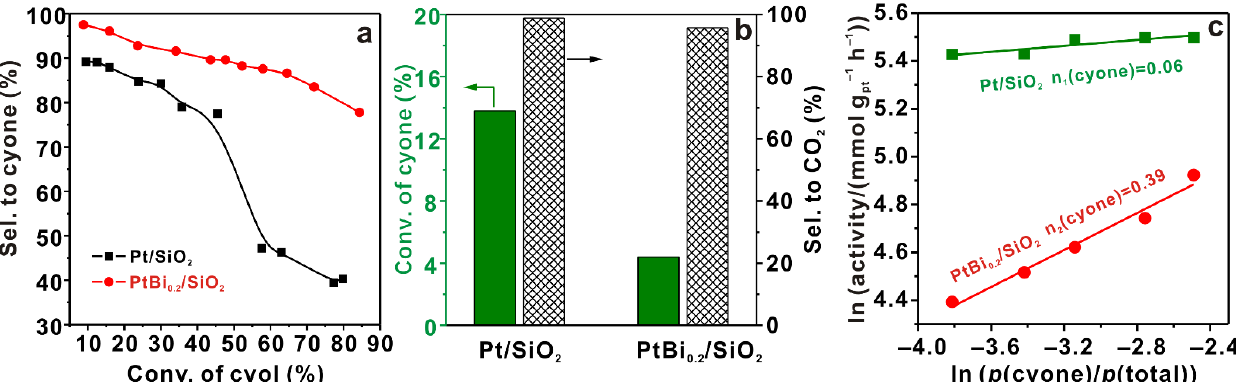
Figure 7. ( a ) Selectivity-conversion trajectories for Pt/SiO 2 and PtBi 0.2 /SiO 2 catalysts in gas-phase ODH of cyclohexanol (cyol). ( b ) Catalytic activities of Pt/SiO 2 and PtBi 0.2 /SiO 2 in total oxidation of cyclohexanone (cyone). ( c ) The influence of cyclohexanone partial pressure on catalytic activities of Pt/SiO 2 and PtBi 0.2 /SiO 2 in total oxidation of cyclohexanone.